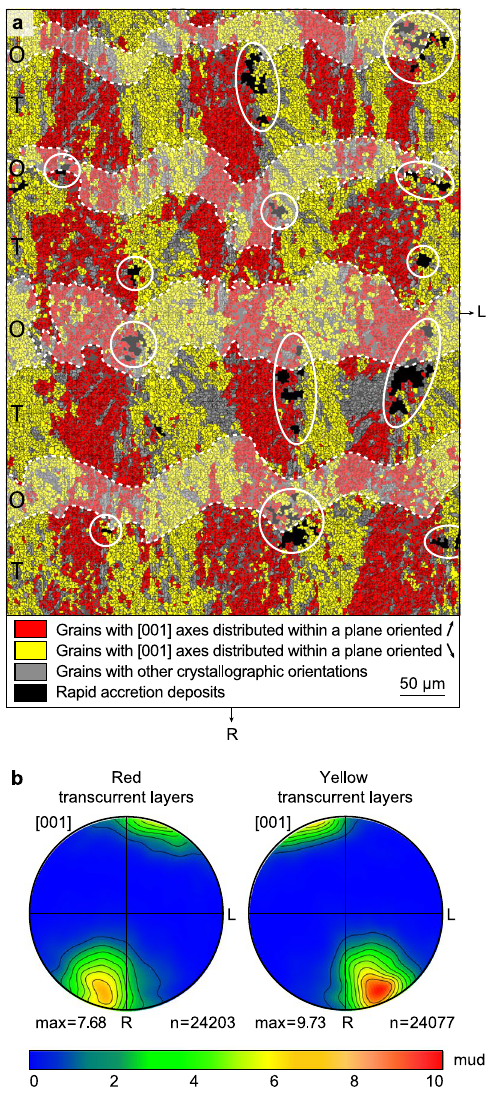
Figure 4. RAD distribution and transcurrent layering. ( a ) Dichromic EBSD map of the area squared in Fig. 2 showing the occurrence of continuous transcurrent layers normal to the corallite wall. Pixels of the same colour have [001] axes oriented within the same reference plane (within a tolerance of ± 15°). The reference plane for the red pixels has a strike of N25°E, whereas that for the yellow pixels is N25°W. Both reference planes are normal to the section. RADs are indicated by white ellipses and opaque bands are shown by dashed lines. ( b ) Pole figures of aragonite [001] axes for the left and right transcurrent layers represented on lower hemisphere equal area projections. Contours have been generated using a Gaussian half-width of 12° using only one point per grain to avoid bias caused by possibly non-uniform grain sizes. The total number of grains (n) used for calculation is shown at the bottom right of each plot (adjacent grains were considered distinct for misorientation > 5°). The maximum orientation density expressed in multiples of uniform distribution (mud, scale bar) is indicated. R and L as in Figs 2 and 3. Opaque (O) and translucent (T) bands are